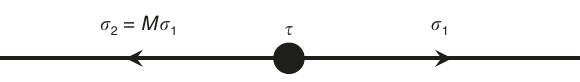
Fig. 6 Cell decomposition for a 1D system with a mirror-re fl ection symmetry. σ 1 and σ 2 denotes two 1-cells related by the mirror symmetry M , and the dot labeled by τ is the 0-cell